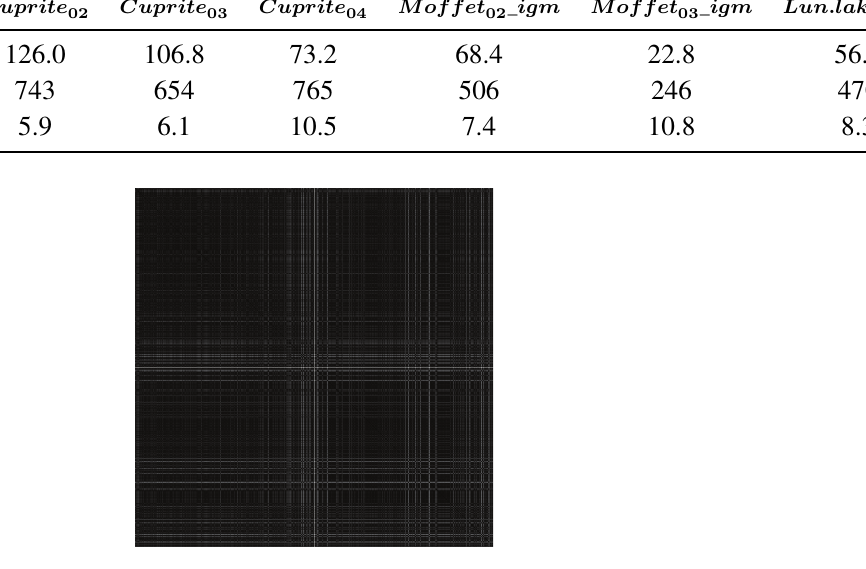
Figure 3. Normalized pairwise-distance matrix image of an outlier and 512 normal pixels in Cuprite 02